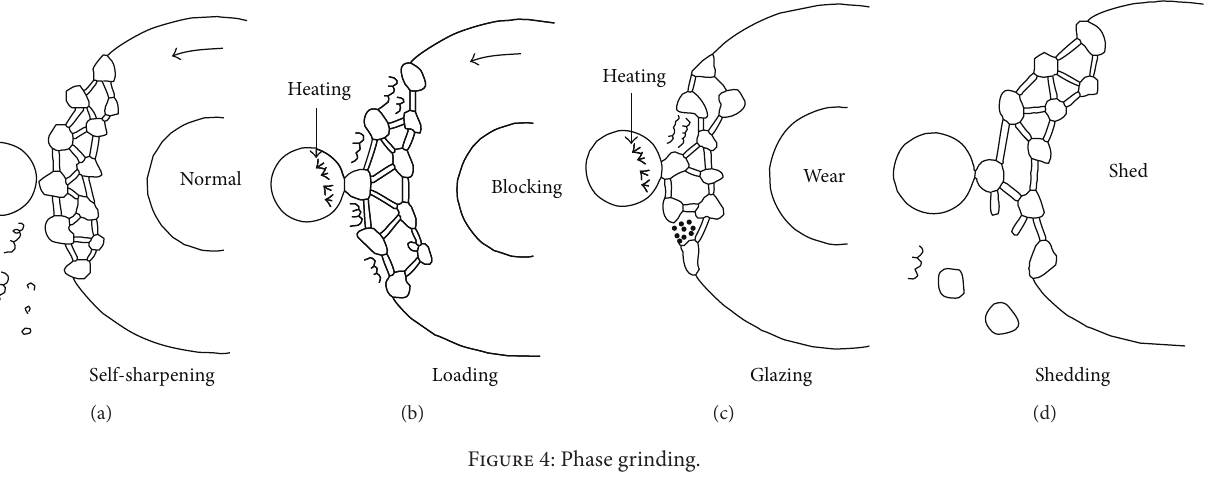
Figure 4: Phase grinding.